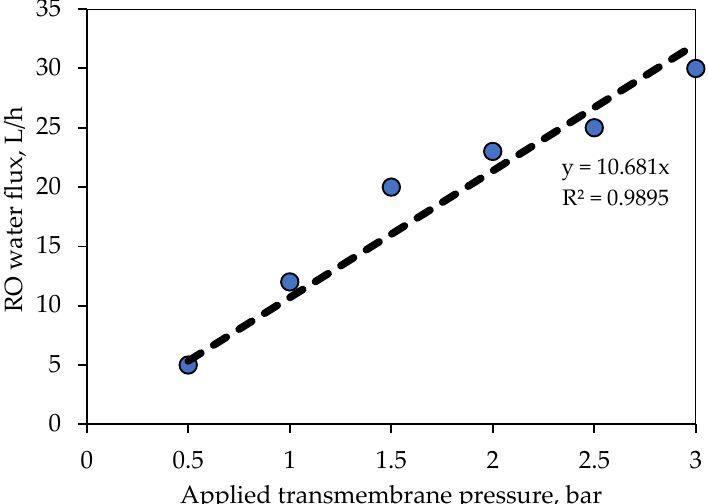
Figure A3. RO water permeate flux versus transmembrane pressure of the ceramic membrane at CFV 1 m/s.